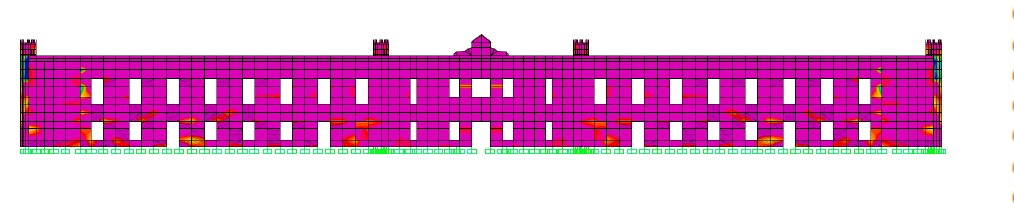
Figure 18. Map of the horizontal axial stresses (MPa) from the linear sequential model, front and rear views.